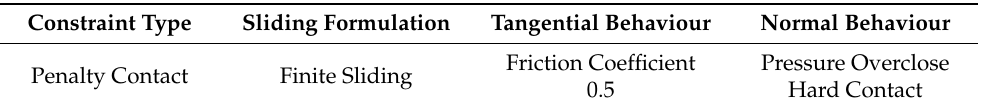
Table 8. Surface-to-surface contact properties.